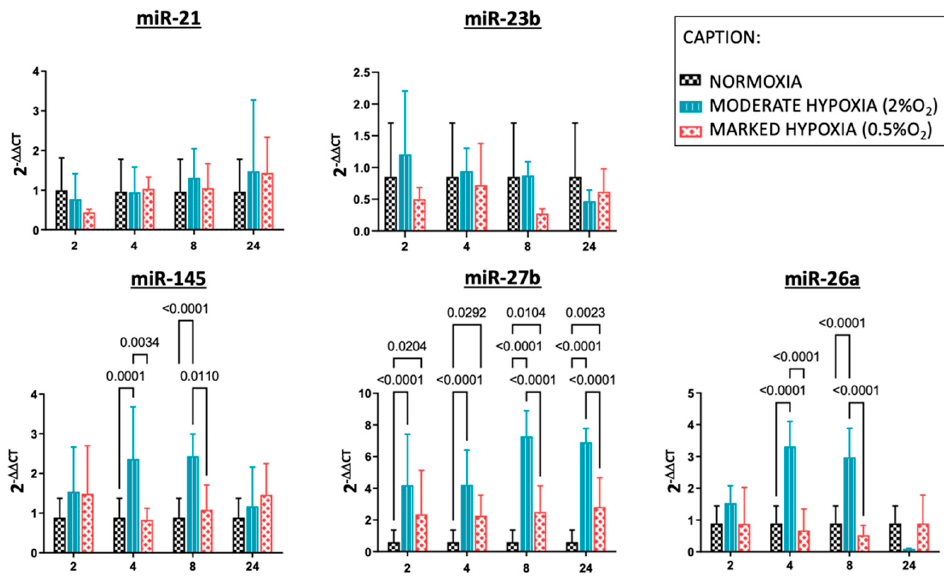
Figure 1. Expression of different miRNAs in normoxia, moderate continuous hypoxia (2% O 2 ) and marked continuous hypoxia (0.5% O 2 ). Quantitative real-time PCR analysis of differentially expressed microRNAs (miRNAs) in Caco-2 cells in condition of moderate (light blu) and marked (red) continuous hypoxia and normoxia (black). RNU-6B was used as endogenous control. The x axis shows the different times of exposure to hypoxia while the y axis shows the expression of each miRNA. Data represent the mean ± SD. * p < 0.05. miR-21 and miR-23 show no significant difference. The levels of nearly all analyzed miRNAs were greater in moderate hypoxia versus marked hypoxia.